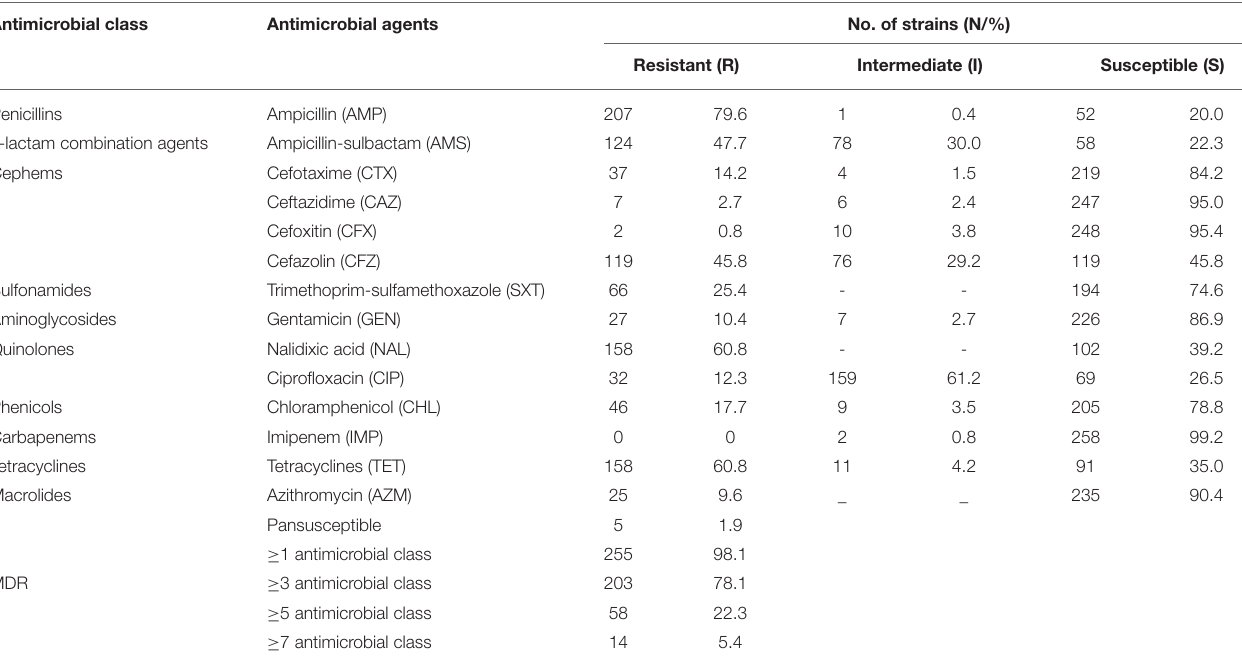
TABLE 2 | The resistance of NTS isolates from diarrheal children in 2014–2019. Antimicrobial class Antimicrobial